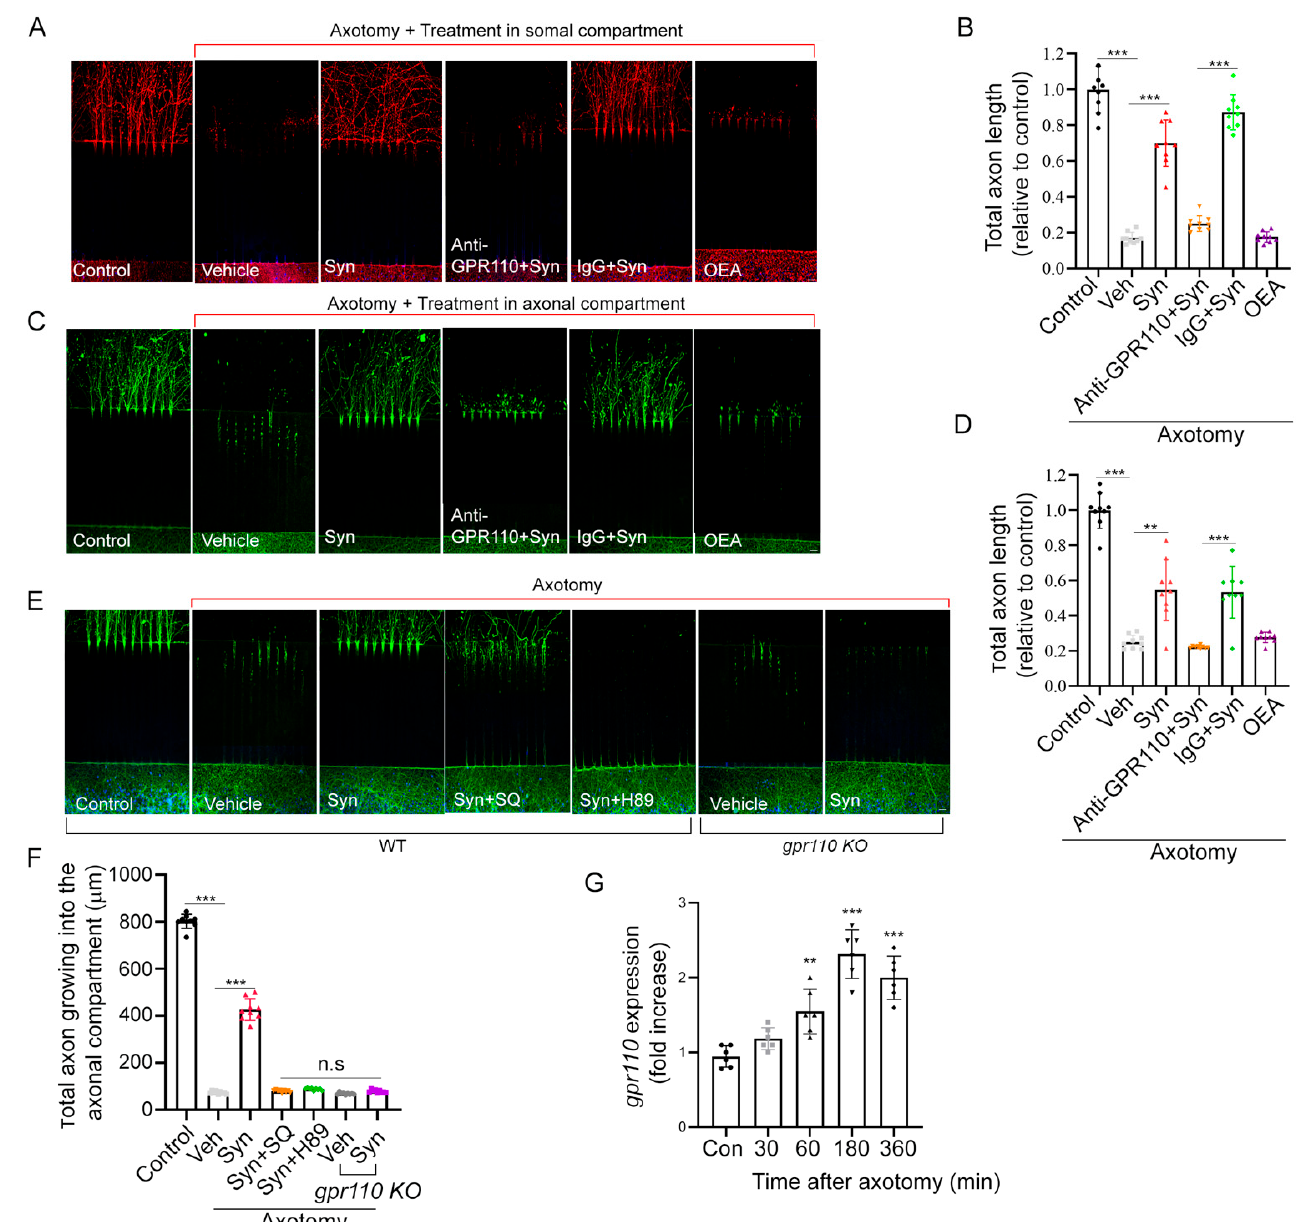
Figure 2. Synaptamide stimulates axon regeneration in vitro through GPR110/cAMP/PKA-dependent signaling. ( A – D ), Stimulated axon regrowth by somal ( A , B ) or axonal treatment ( C , D ) with 10 nM synaptamide, visualized by β -III tubulin immunostaining and quantified by measuring the total axon length in the axonal compartment 7 days after axotomy. ( E , F ), Effect of cAMP (SQ22536, 10 µM) and PKA (H89, 10 µM) inhibitors, N -terminal targeting GPR110 antibody (0.4 mg/mL), or gpr110 KO on synaptamide-induced axon regrowth with quantitative results normalized to the non-axotomized control. G, Time-dependence of axotomy-induced increase in gpr110 expression measured by qRT-PCR. Data are expressed as mean ± s.e.m. with n = 9 for ( B , D , F ) and n = 6 for ( G ) per group. ** p < 0.01, *** p < 0.001, Con, non-axotomized control; Veh, vehicle (DMSO); Syn, synaptamide. Scale bars, 20 µm. n.s, statistically not significant.